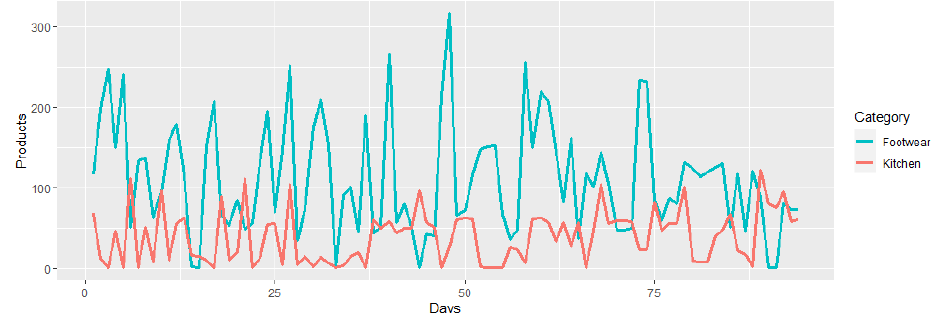
Figure A7. Products per day; Footwear vs. Kitchen.